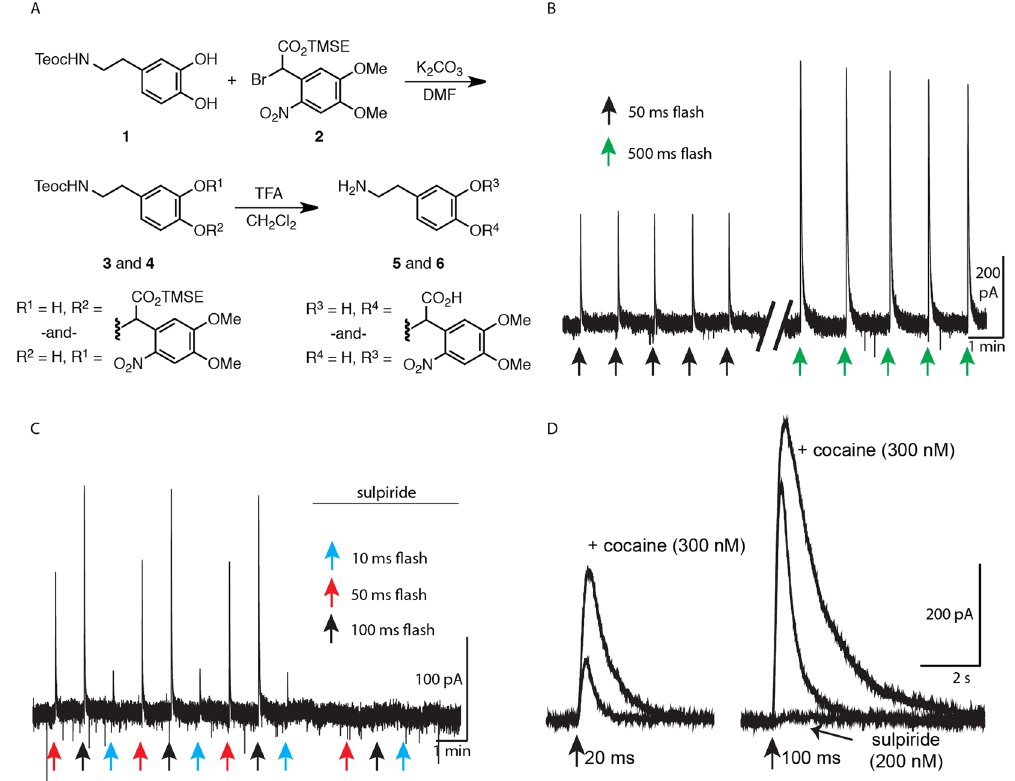
Figure 3. Synthesis and photolysis of caged dopamine. ( A ) Synthetic rout to caged dopamine (CNV-dopamine, 5 and 6). See methods for detailed explanation. ( B ) The caged dopamine compound was photolysed with LED flashes of 365 nm. When flashes were conducted with a 60 second interval, there was little to no rundown of the resultant D2-GIRK current with flash lengths up to 100 ms. Even with longer 500 ms flashes, only a modest decrease in current was observe. This was likely due to receptor desensitization rather than compound rundown. ( C ) All flash-induced currents were completely abolished by the addition of sulpiride to the caged dopamine reperfusion solution indicating the dopamine being uncaged acted solely on the D2 receptor. ( D ) Application of the dopamine transporter (DAT) blocker cocaine increases the amplitude and prolongs the signaling of the flash currents indicating that the uncaged dopamine is taken up through the